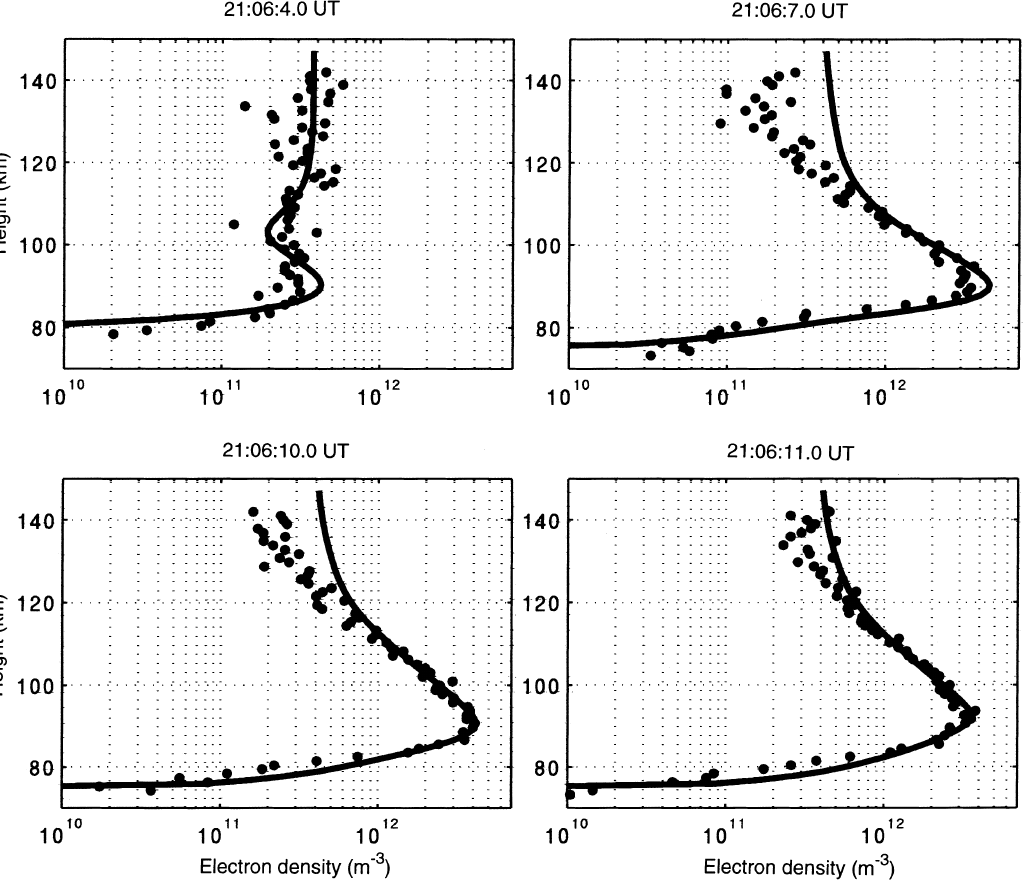
Fig. 7. Full model results of electron density profiles ( line ) and measured electron density profiles at 0.2-s resolution (